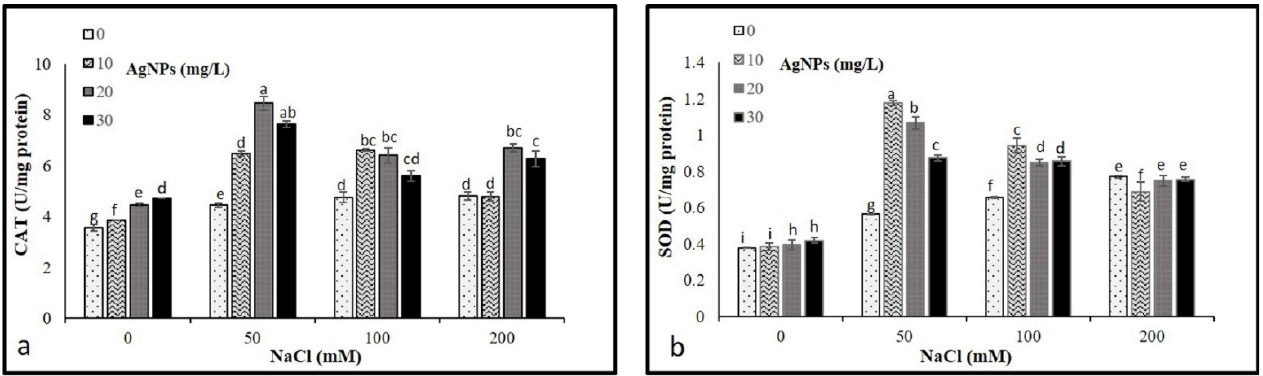
Figure 7. Activities of antioxidant enzymes ( a ) CAT and ( b ) in Maerua oblongifolia leaves under salt stress and application of silver nanoparticles. Means ± SD for each treatment followed by the same letters are not significantly different according to the Duncan’s test ( p ≤